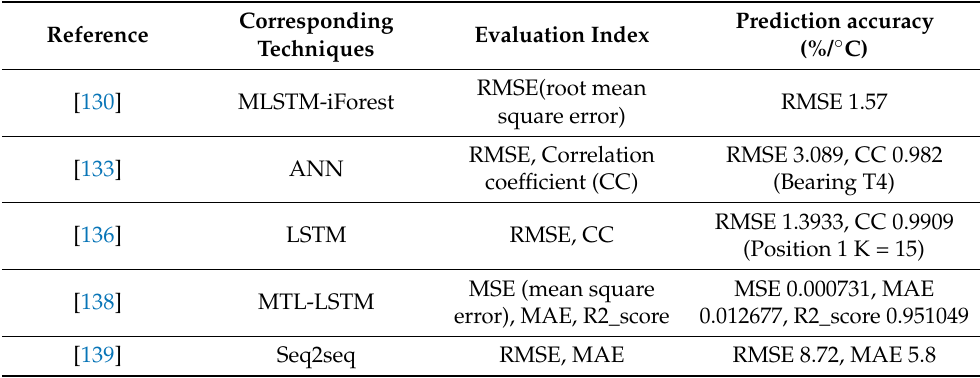
Table 4. Partial temperature forecasting models in the